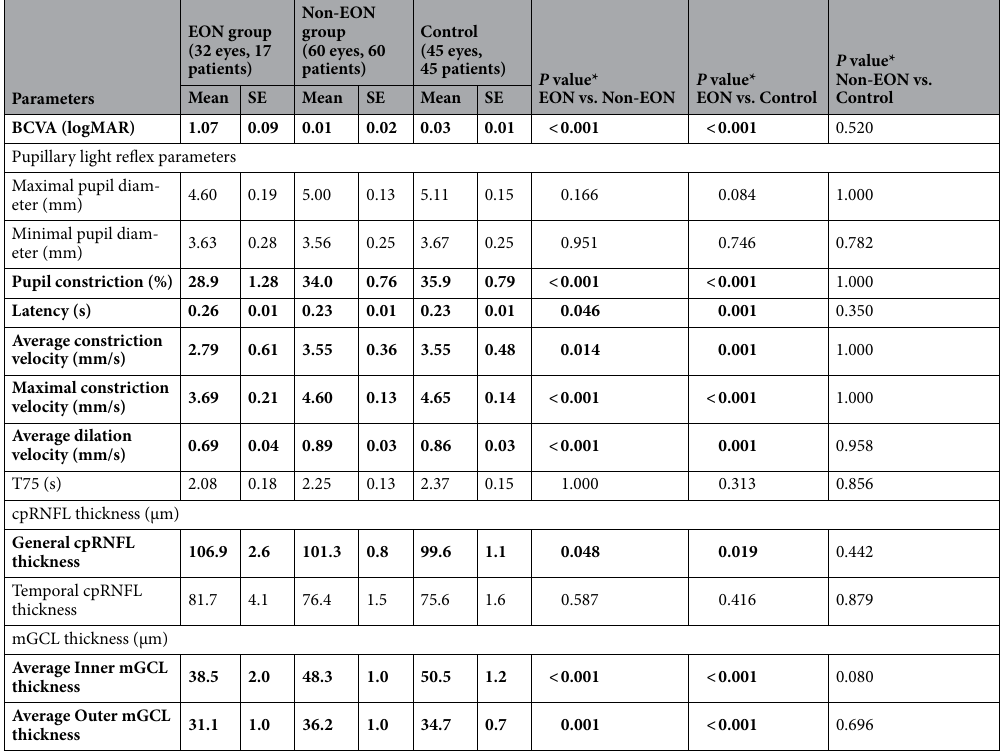
Table 1 summarizes